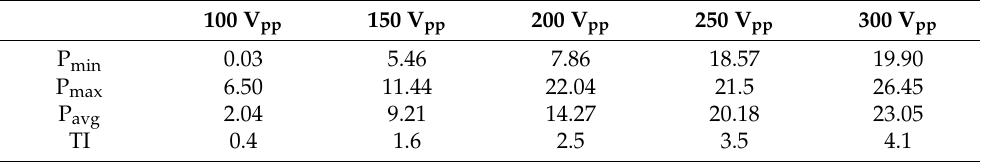
Table 1. Results of acoustic power and TI under different driving conditions.